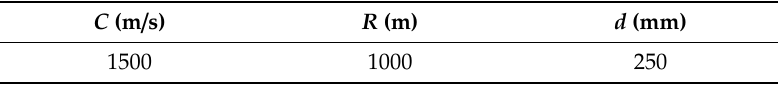
Table 2. Location environment and equipment